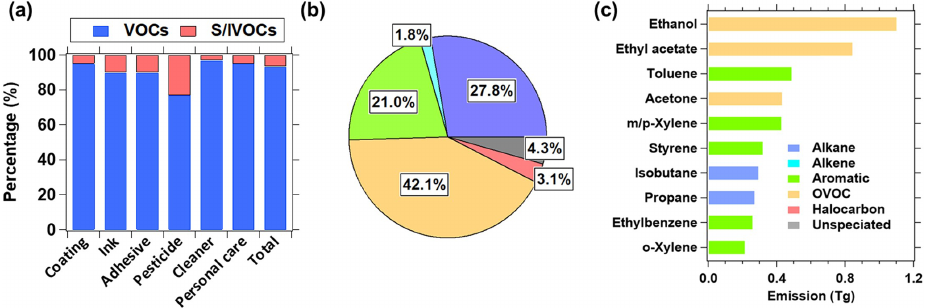
Figure 4. (a) Contributions of VOCs and S/IVOCs, (b) NMVOC functional group pattern, and (b) the top 10 species in NMVOC emissions in 2017 from solvent